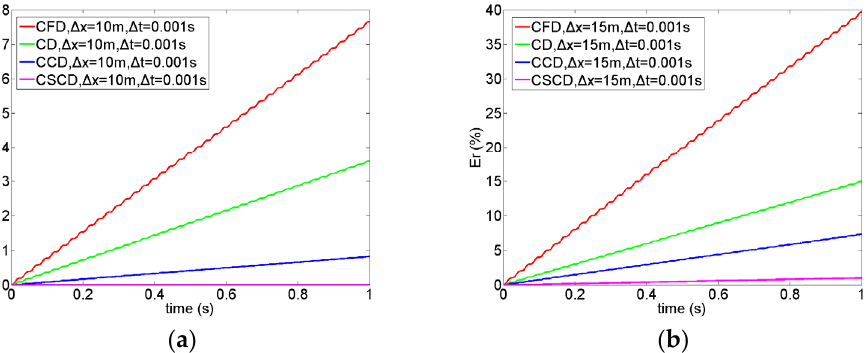
Figure 2. Relative errors of numerical simulation for different schemes and gird size: ( a ) Δ x = 10 m, Δ t = 0.001 s; ( b ) Δ x = 15 m, Δ t = 0.001 s.